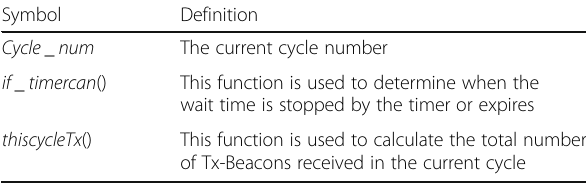
Table 3 Symbols used in Algorithm 1 and their